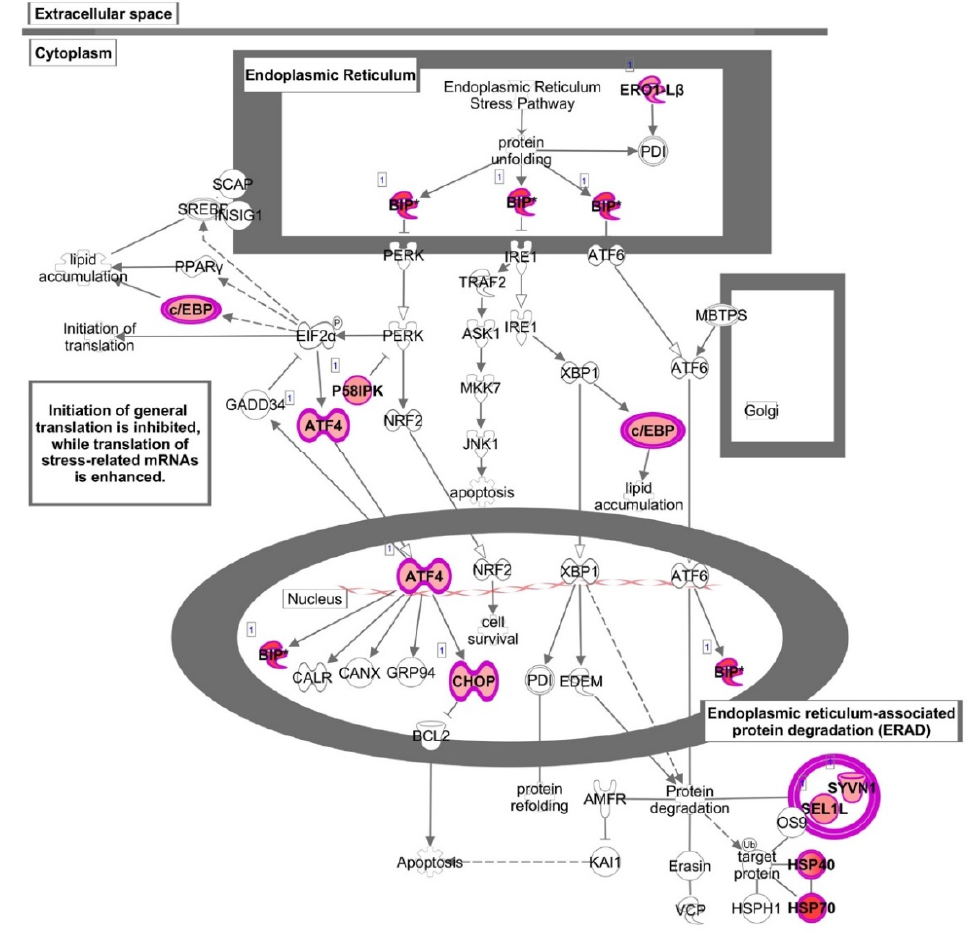
Figure 6. Canonical pathway representing “Unfolded protein response” obtained with Ingenuity Pathway Analysis (IPA) from the analysis of data set modulated by HT. Genes which expression was significantly modulated by HT are depicted together with others involved in the cascade (but not significantly modulated, depicted in gray). Complex or groups of genes are surrounded by a double line. Up ‐ regulated genes are depicted in red.